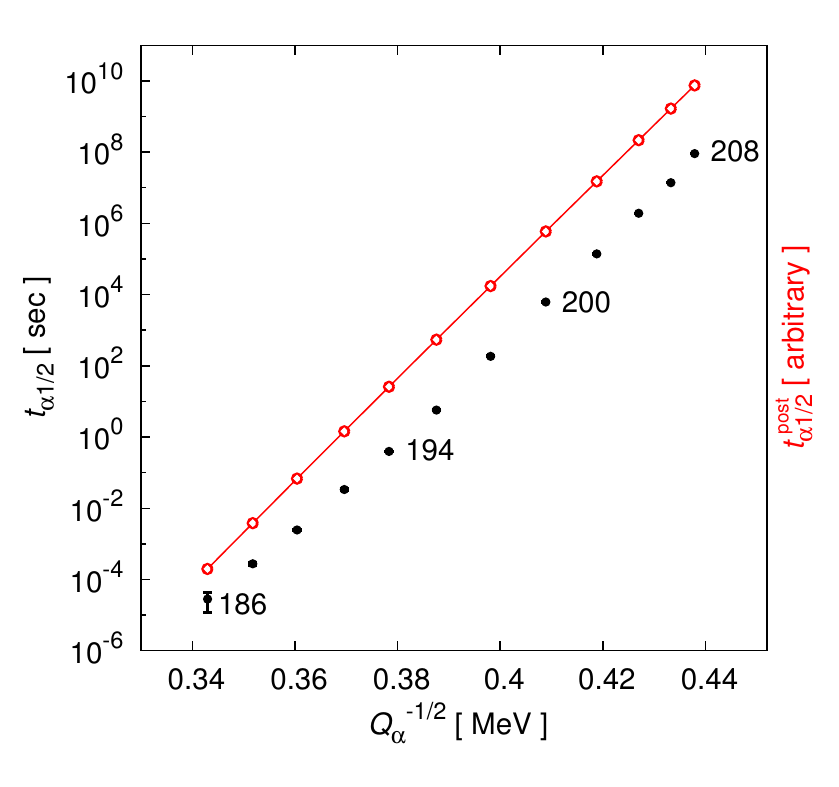
Figure 2. Half-lives, t 1 / 2 , of Polonium isotopes as a function of the inverse of the square root of Q α . The filled black points are the experimental data. The red open circles are the calculations with the post-formation hypothesis using formula (9) for ppnn individual tunneling case.